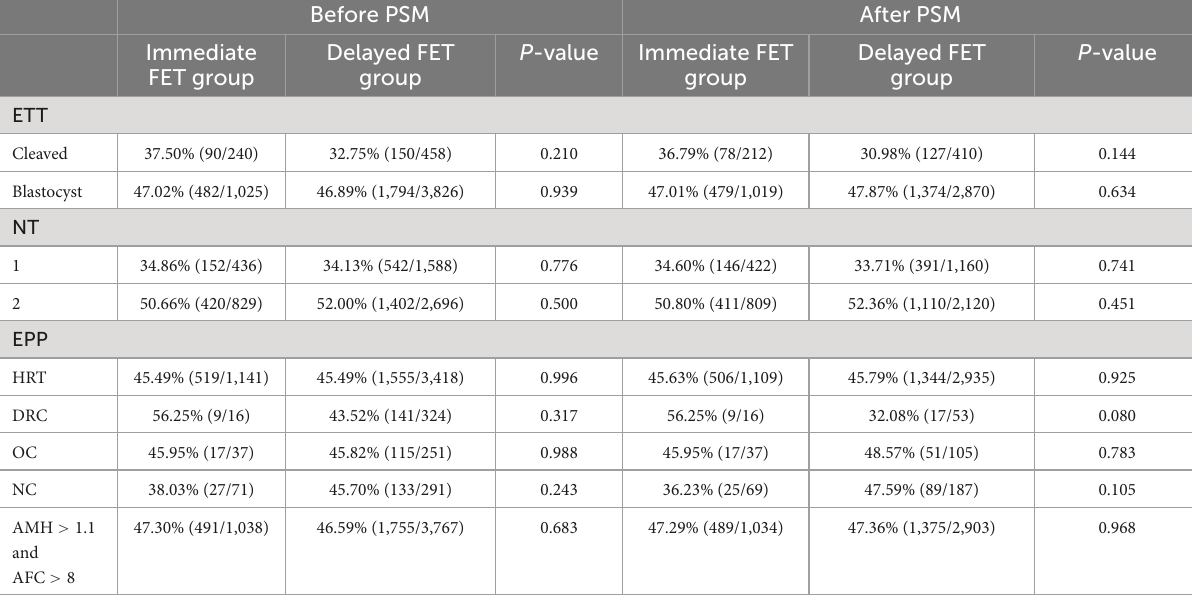
TABLE 4 Stratified analysis comparing the live birth rate between the immediate FET and delayed FET groups. Before PSM